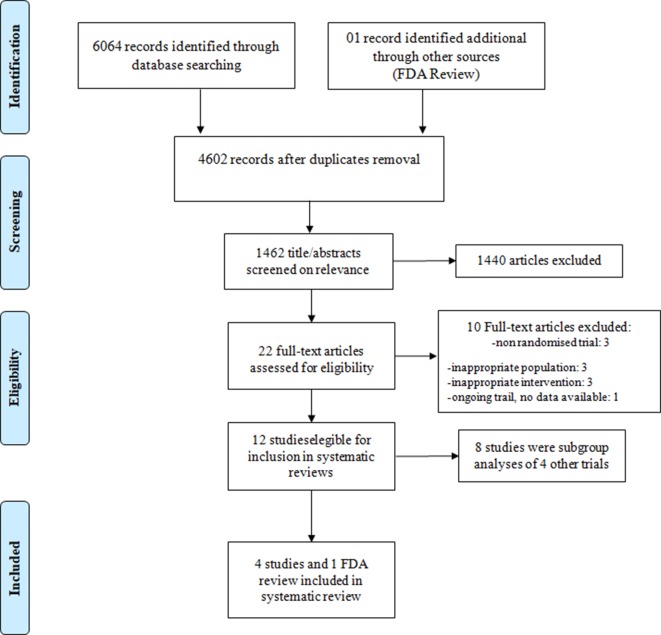
Preferred reporting items for systematic reviews and meta-analyses (PRISMA-P) flow diagram: search and selection process.